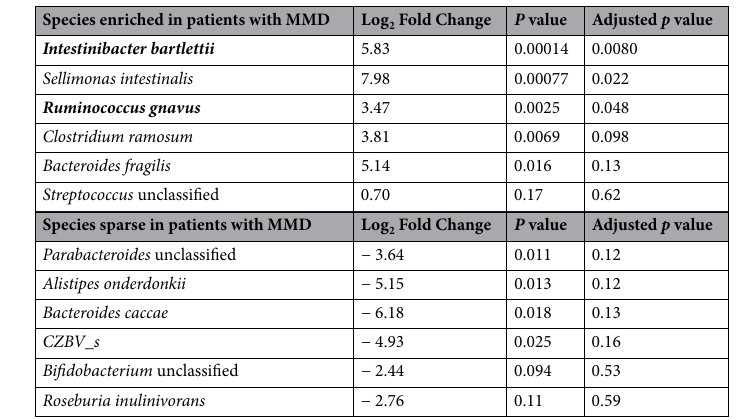
Table 2. Differential abundance analysis using DESeq2 between patients with MMD and controls. Microbial taxa shown to be associated with MMD in both LEfSe and DESeq2 analyses are shown in